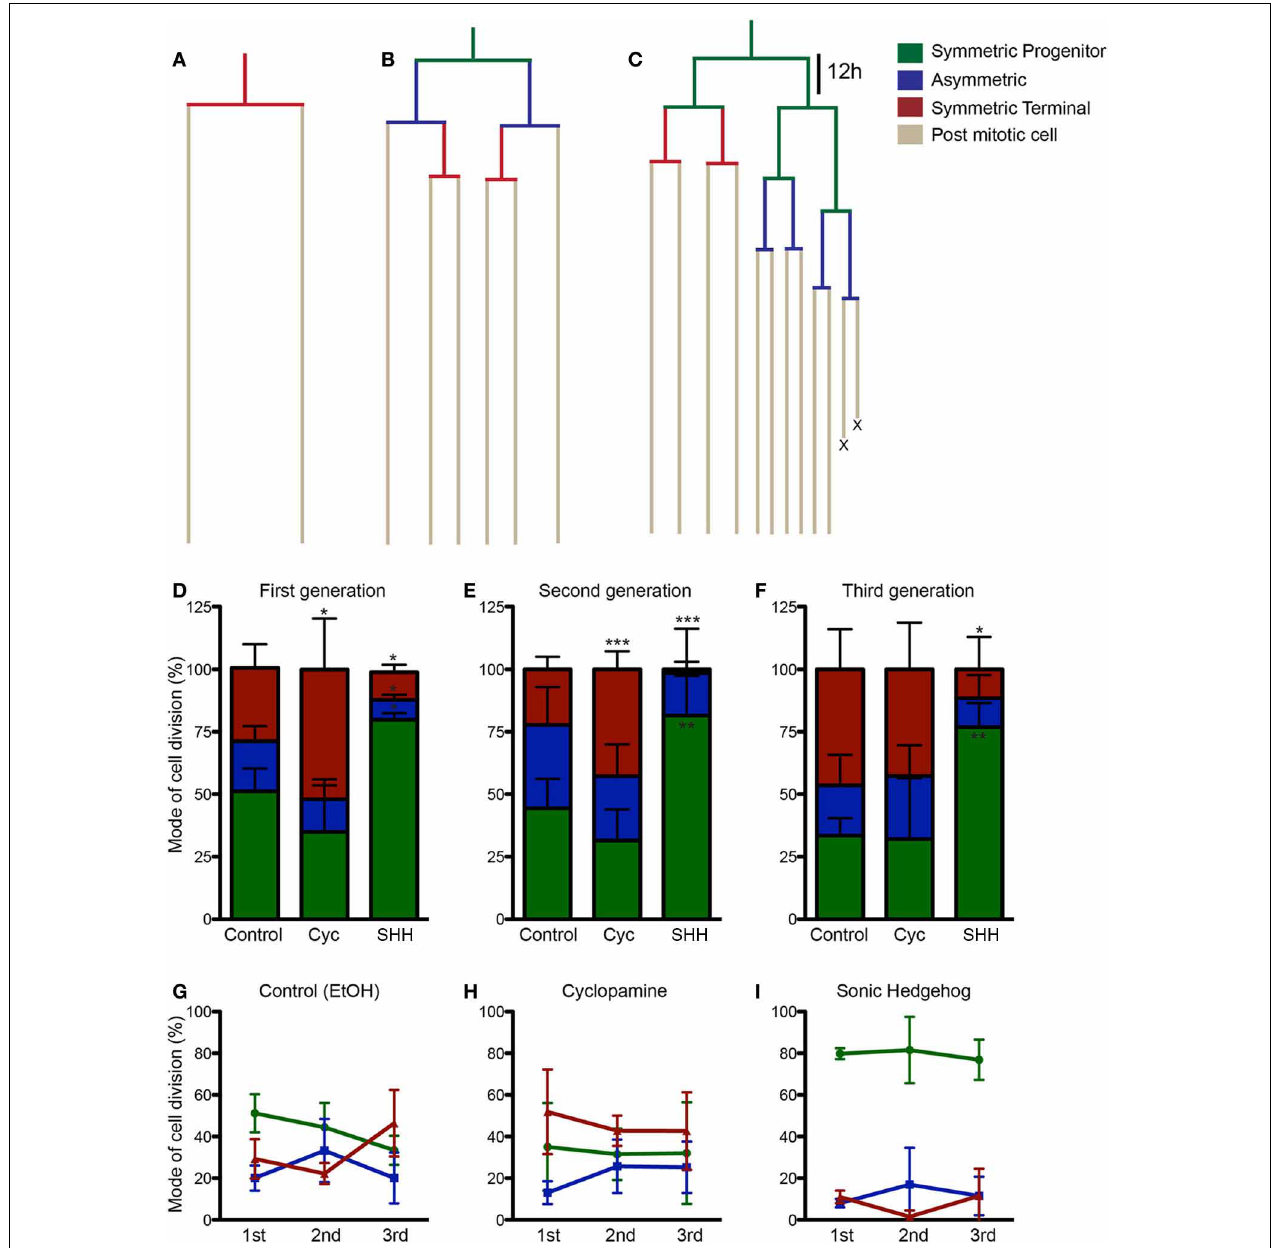
FIGURE 4 | SHH increase frequency of progenitor cell divisions. (A–C) Examples of lineages trees from individual cortical progenitors observed in cyclopamine (A) , control (B) and SHH (C) treated cultures. Lines are color coded to indicate cells undergoing SP (green), As (blue), or ST (red) cell divisions. (D–F) Quantification of SP, As and ST cell divisions in the first (D) , second (E), and third (F) cell generations. (G–I) Graphics showing the evolution in the frequency of SP, As and ST cell division in the lineage